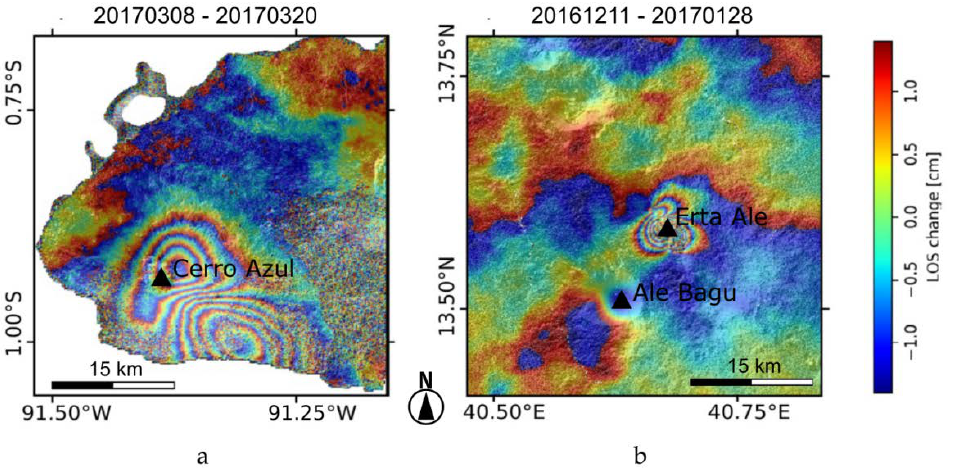
Figure 12. Descending wrapped interferograms generated by the LiCSAR system showing ground deformation associated with ( a ) the March 2017 intrusion at Cerro Azul and ( b ) the January 2017 intrusion at Erta Ale.